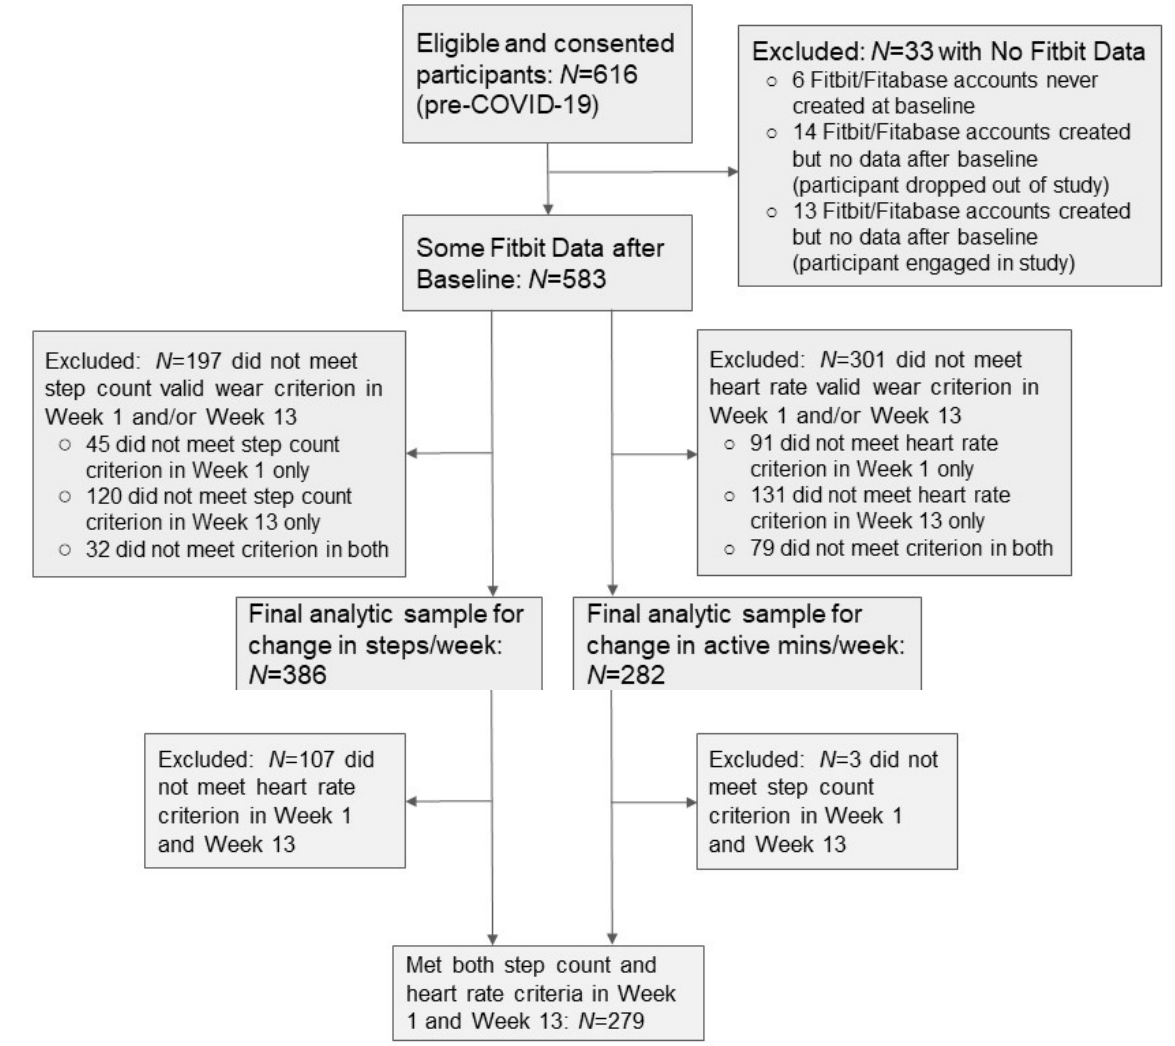
Figure 1. Flow diagram for analytic samples.